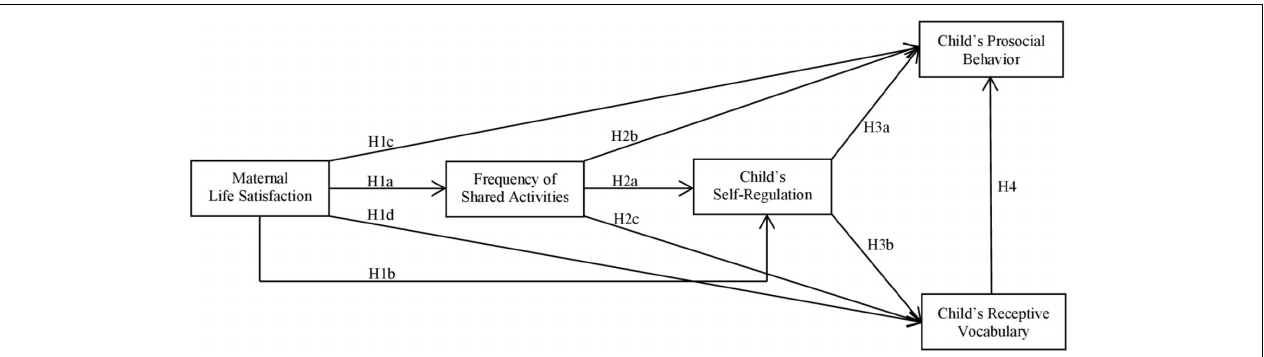
FIGURE 1 | Well-being of family and child: Model of hypothesized relationships between maternal life satisfaction, frequency of shared parent-child activities as well as self-regulation, prosocial behavior and receptive vocabulary.